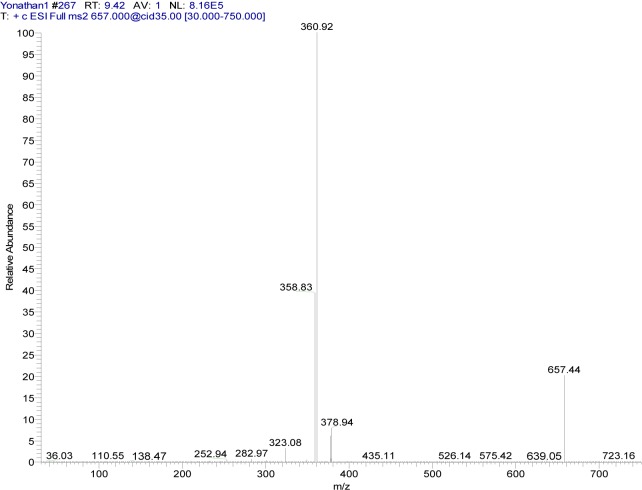
Positive ion mode ESI-CID-MS2 spectrum of the ion [65Cu(C17H13ClN2O)2]+ at m/z 657.44 (cationic unit of 5a complex)